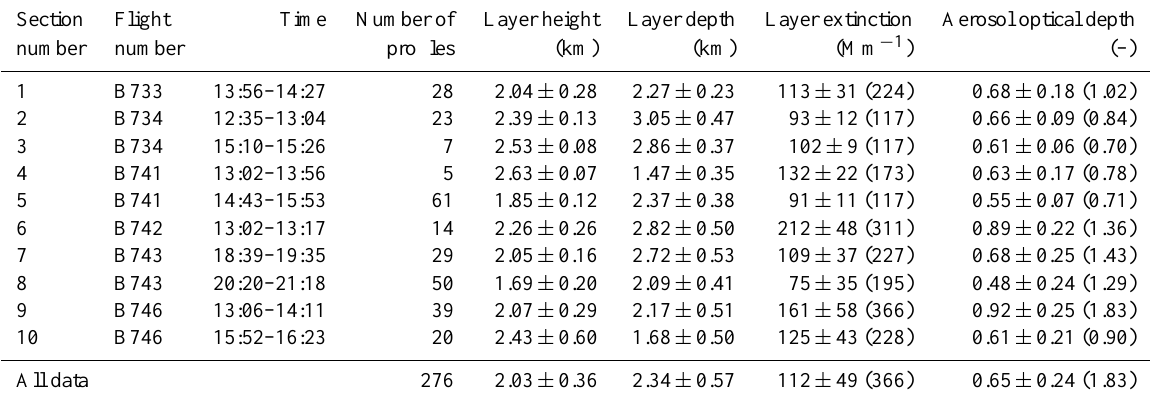
Table 2. Flight sections considered for the characterisation of the aerosol layer, displayed with red arrows in Fig. 5. For each section, the layer height, layer depth, layer extinction and aerosol optical depth are listed (see text). For each quantity, the average and standard deviation are shown; for the layer extinction and aerosol optical depth, maximum values are shown as well (in parentheses). The results for the whole data set are listed as